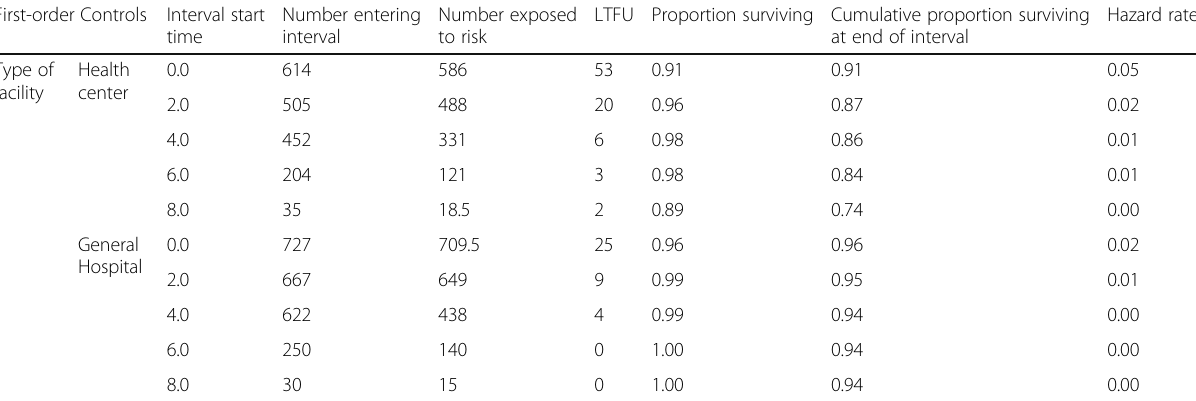
Table 3 Life table for tuberculosis patients ’ loss to follow-up status by type of health facility, for 1341 TB patients enrolled into TB treatment and care at public health facilities, rural Ethiopia, during 2008 – 2015 First-order Controls Interval start Number entering time interval